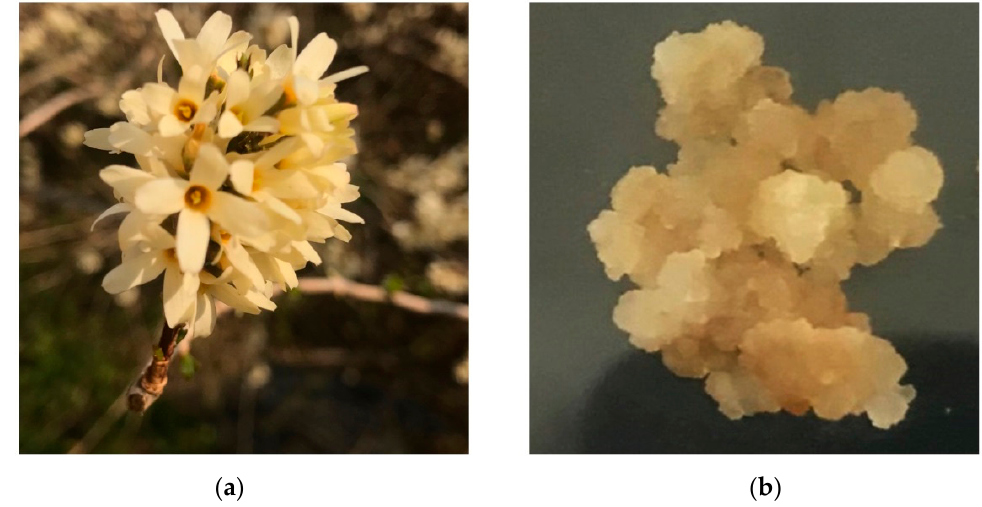
Figure 1. The representative image of ( a ) A. distichum var. Okhwang 1 and ( b ) callus of A. distichum var. Okhwang 1.